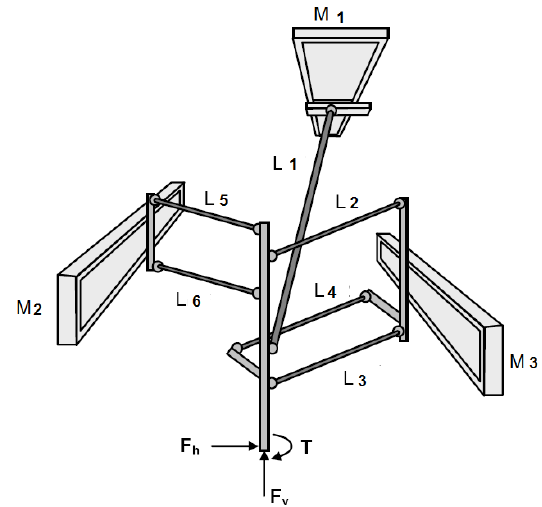
Figure 1: A variant of 3-2-1 link structure mounted on three quide